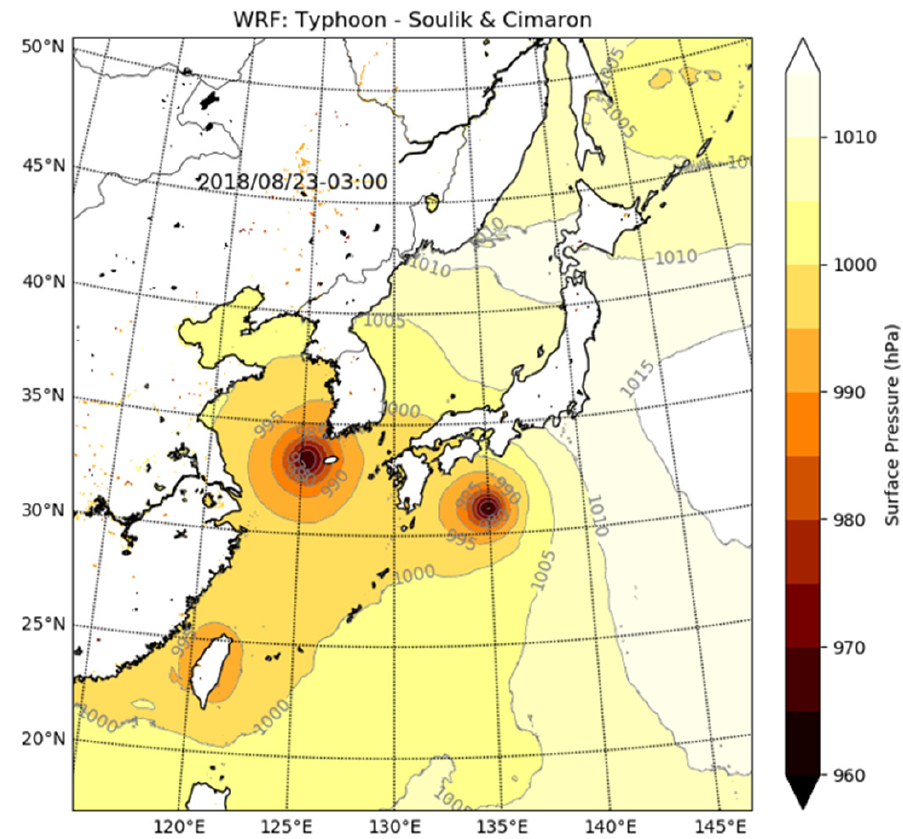
Figure 6. Simulation results for Soulik and Cimaron typhoons using WRF-NWP. Colors: surface pressure, arrows: wind field at 10 m.